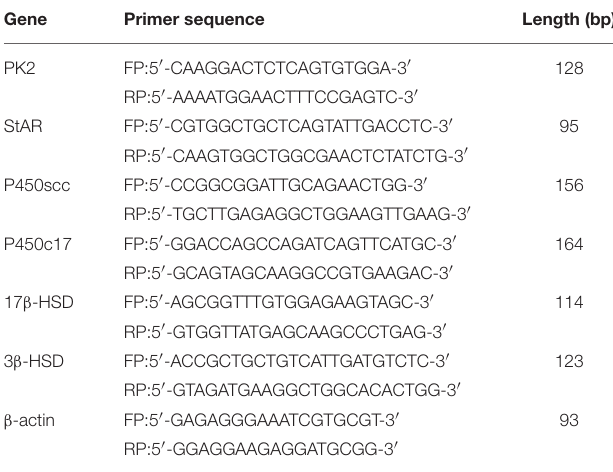
TABLE 1 | Real-time PCR primer